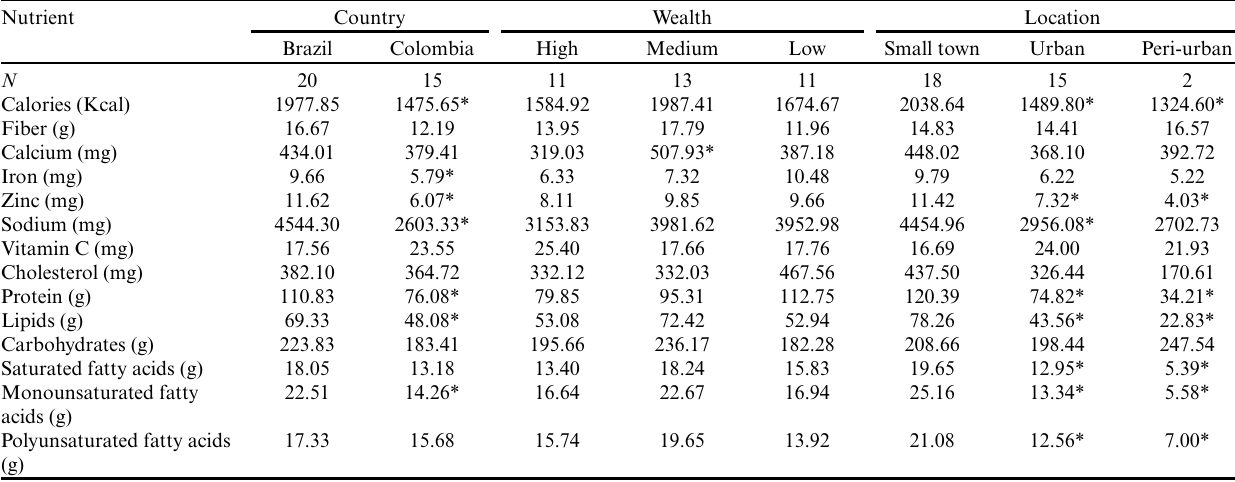
Table 2. Nutrient intake per day per adult in the study households according to socioeconomic characteristics and location. Nutrient